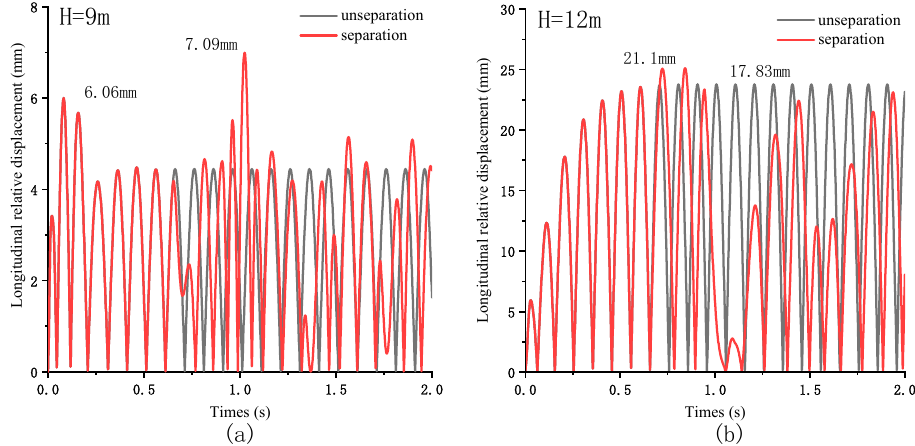
Figure 5. Longitudinal relative displacement of pier beam under different pier height: ( a ) Longitu- dinal relative displacement of pier beam under two conditions of separation or not when H = 9 m; ( b ) Longitudinal relative displacement of pier beam under two conditions of separation or not when H = 11 m.